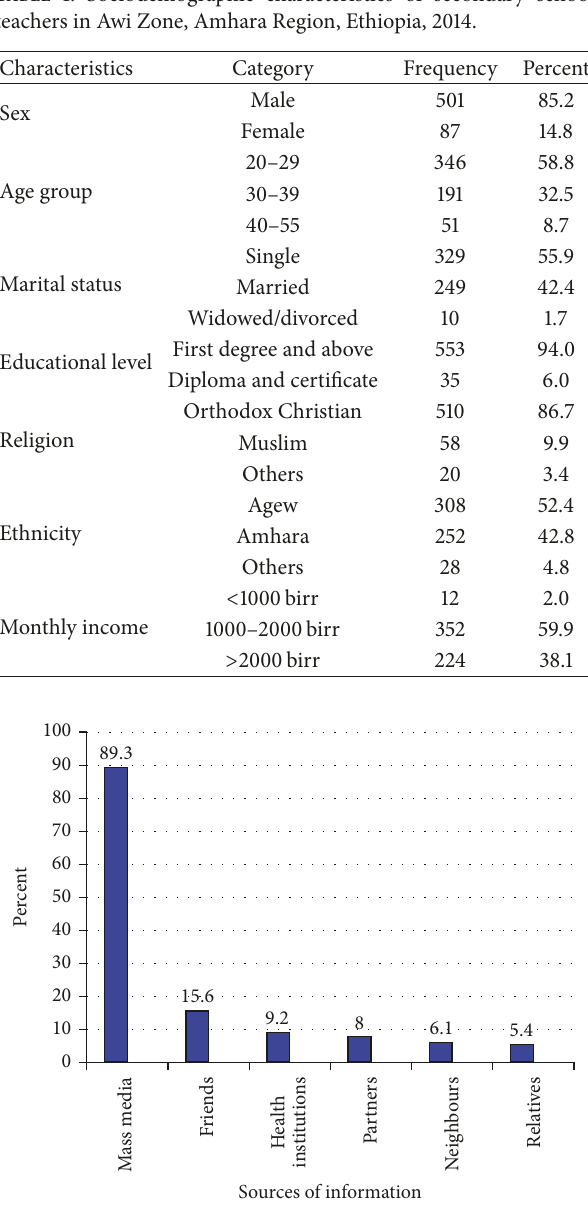
Figure 2: Sources of information about VCT among secondary school teachers in Awi Zone, Amhara Region,